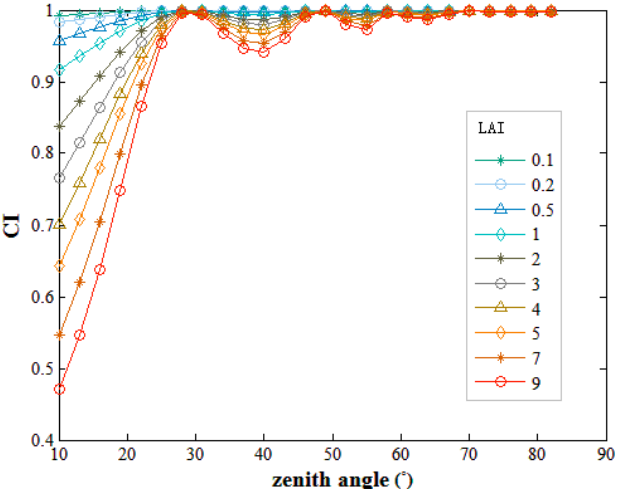
Figure 2. Crop Ω ( θ ) along with zenith angle for different leaf area index (LAI). Other simulation parameters: a 1 = 0.2, a 2 = 0.3, H = 1, r h g = 0.22, ρ = 0.0999, T =